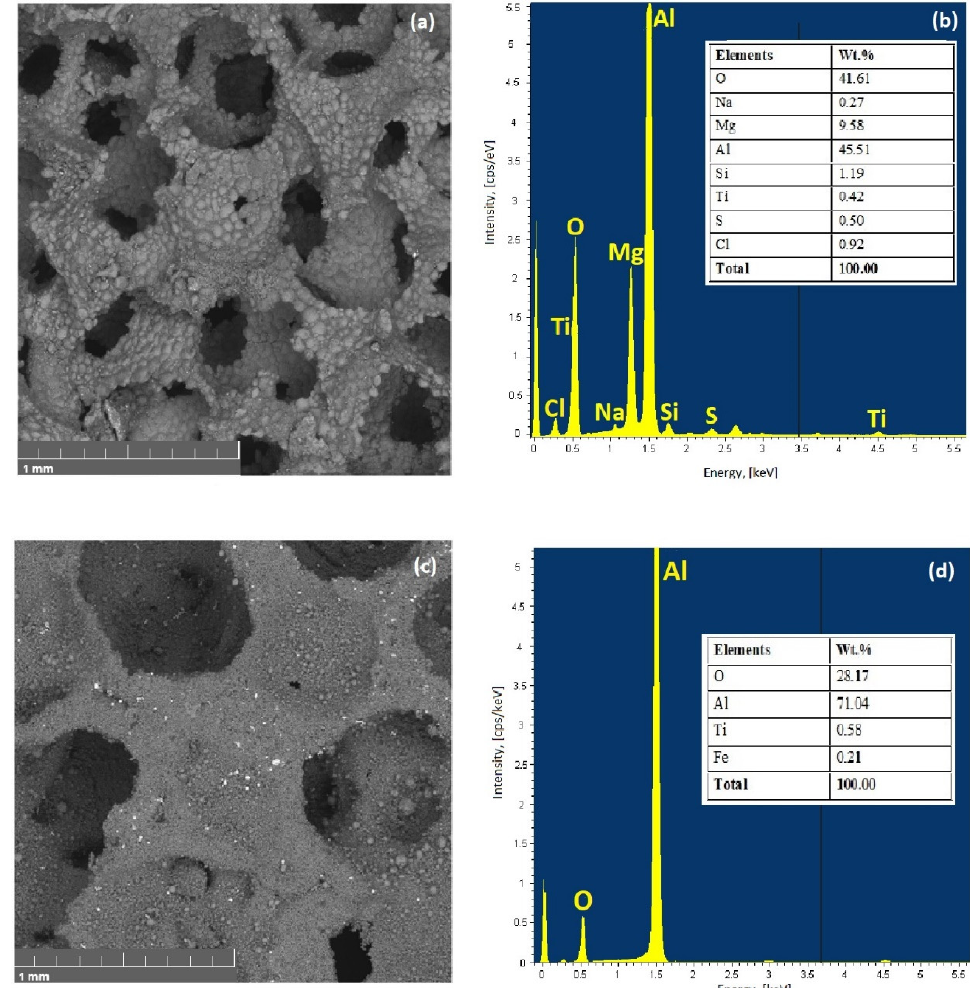
Figure 7. SEM image ( a , c ) and corresponding energy-dispersive X-ray spectroscopy spectra ( b , d ) of SPS sample ( a , b ) and replication sample ( c , d ).